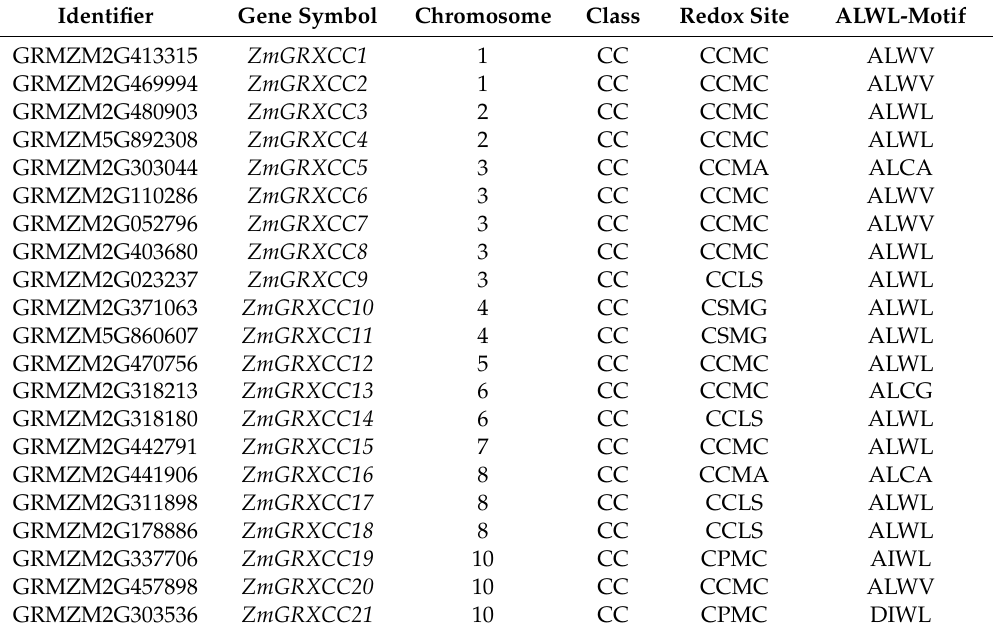
Table 1. Detailed information for the 21 ZmGRXCC genes identified in the Zea mays